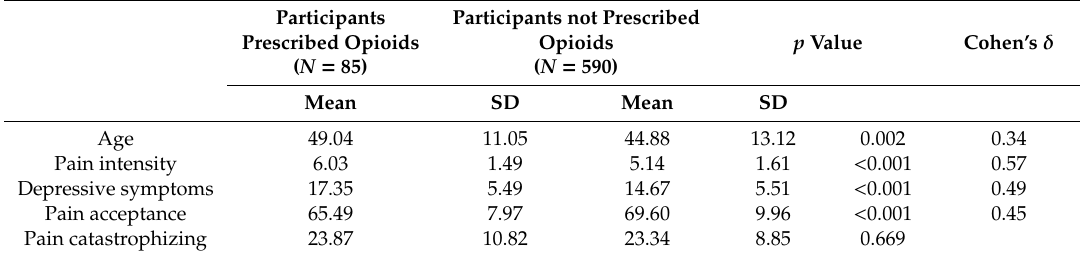
Table 2. Di ff erences between participants who were prescribed and not prescribed opioids.